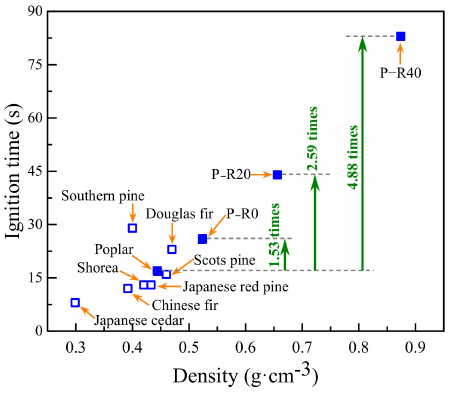
Figure 8. Ignition time of different wood species and modified poplar wood